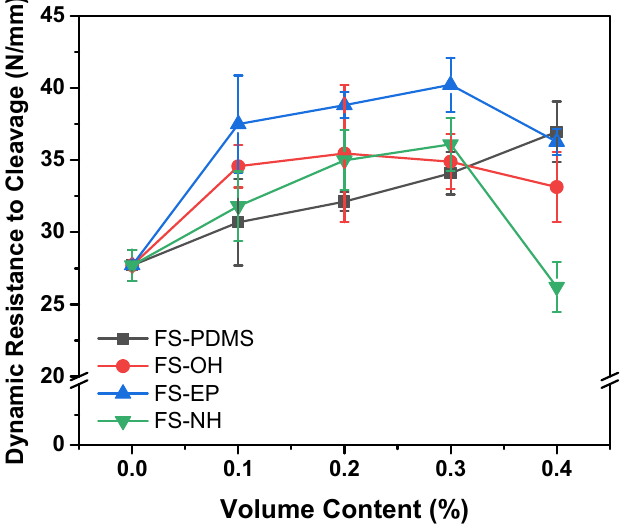
Figure 10. Dynamic resistance to cleavage of epoxy adhesives with different silica nanoparticles content, obtained by the IWP test at room temperature.